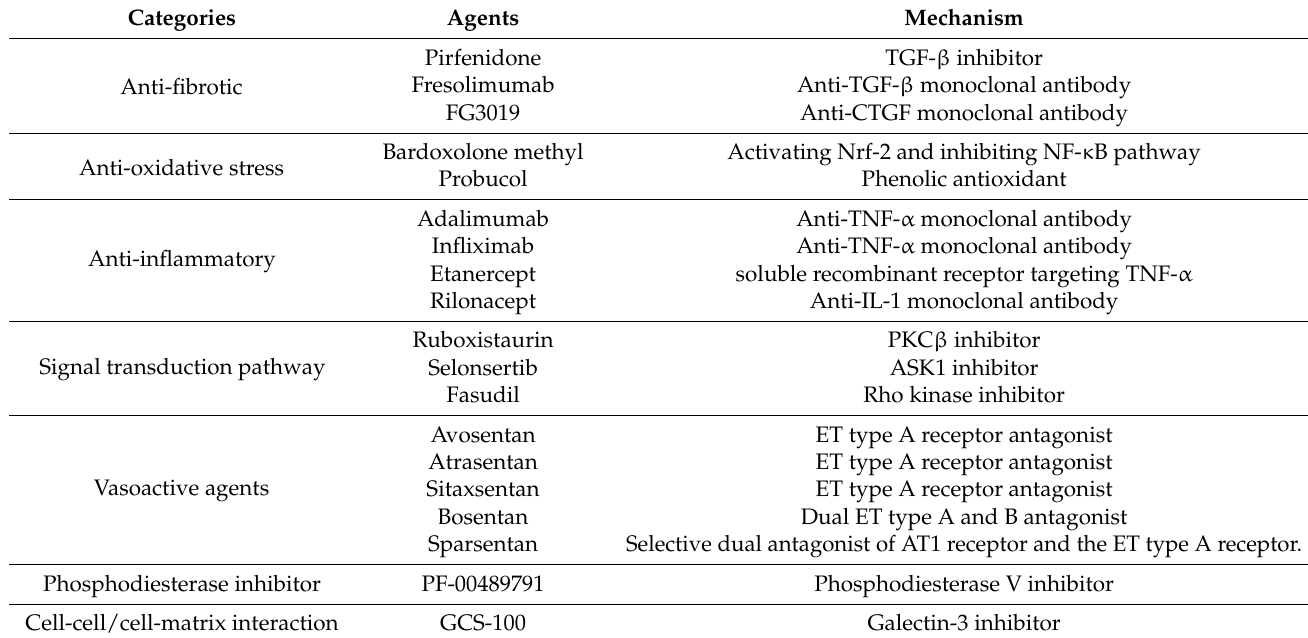
Table 3. Potential novel agents targeting CKD